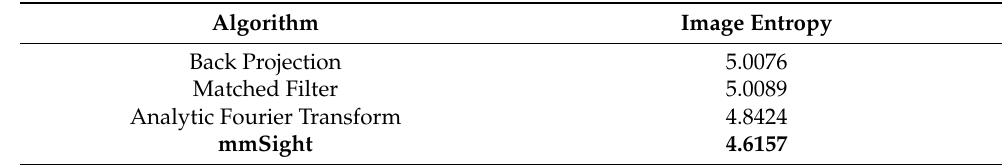
Table 4. Image Entropy of point target (Using formula (16) to calculate, the input is from Figure 16 and the output is IE).